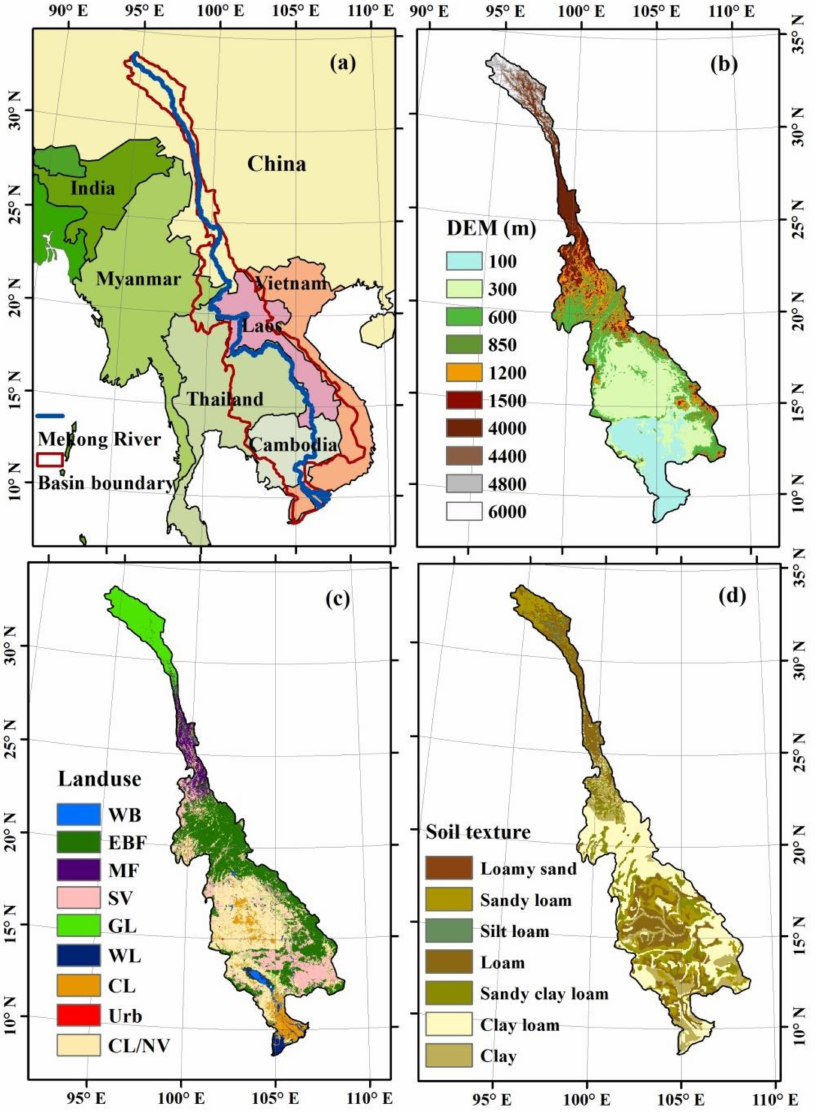
Figure 1. ( a ) Location, ( b ) elevation, ( c ) land-use/cover type and ( d ) soil texture in the Mekong River Basin (MRB) (WB: Water body, EBF: Evergreen broadleaf forest, MF: Mixed forest, SV: Savanna, GL: Grassland, WL: Wetland, CL: Cropland, Urb: Urban and built-up, CL/NV: Cropland and natural vegetation